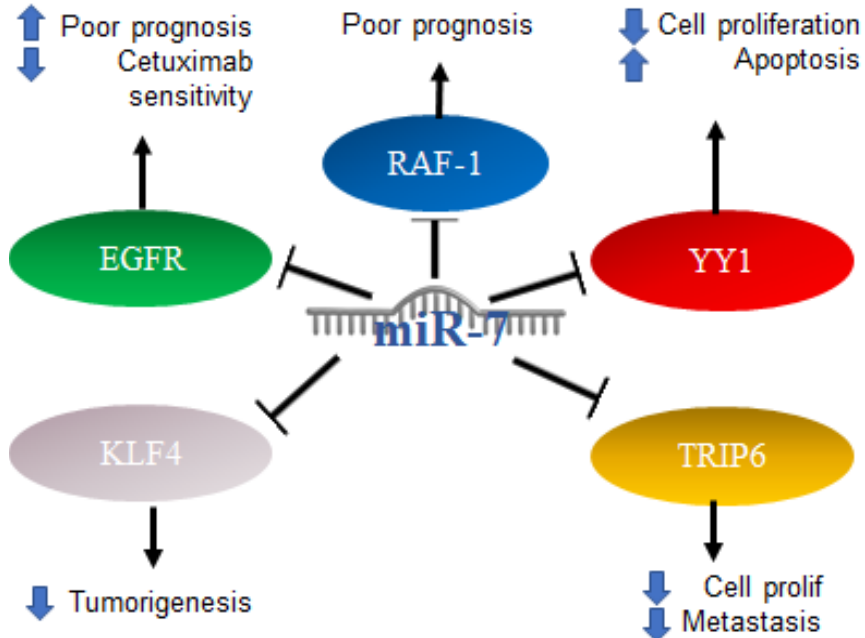
Figure 7. Role of miR-7 in colorectal cancer. Schematic representation of protein interactions with miR-7 and its biological consequences in colorectal cancer.